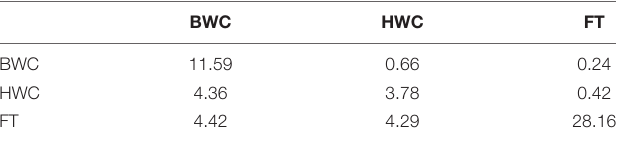
Genetic variance of the traits is presented on the diagonal; the upper diagonal shows the genetic correlation between the traits, and the lower diagonal is the genetic covariance between the traits.